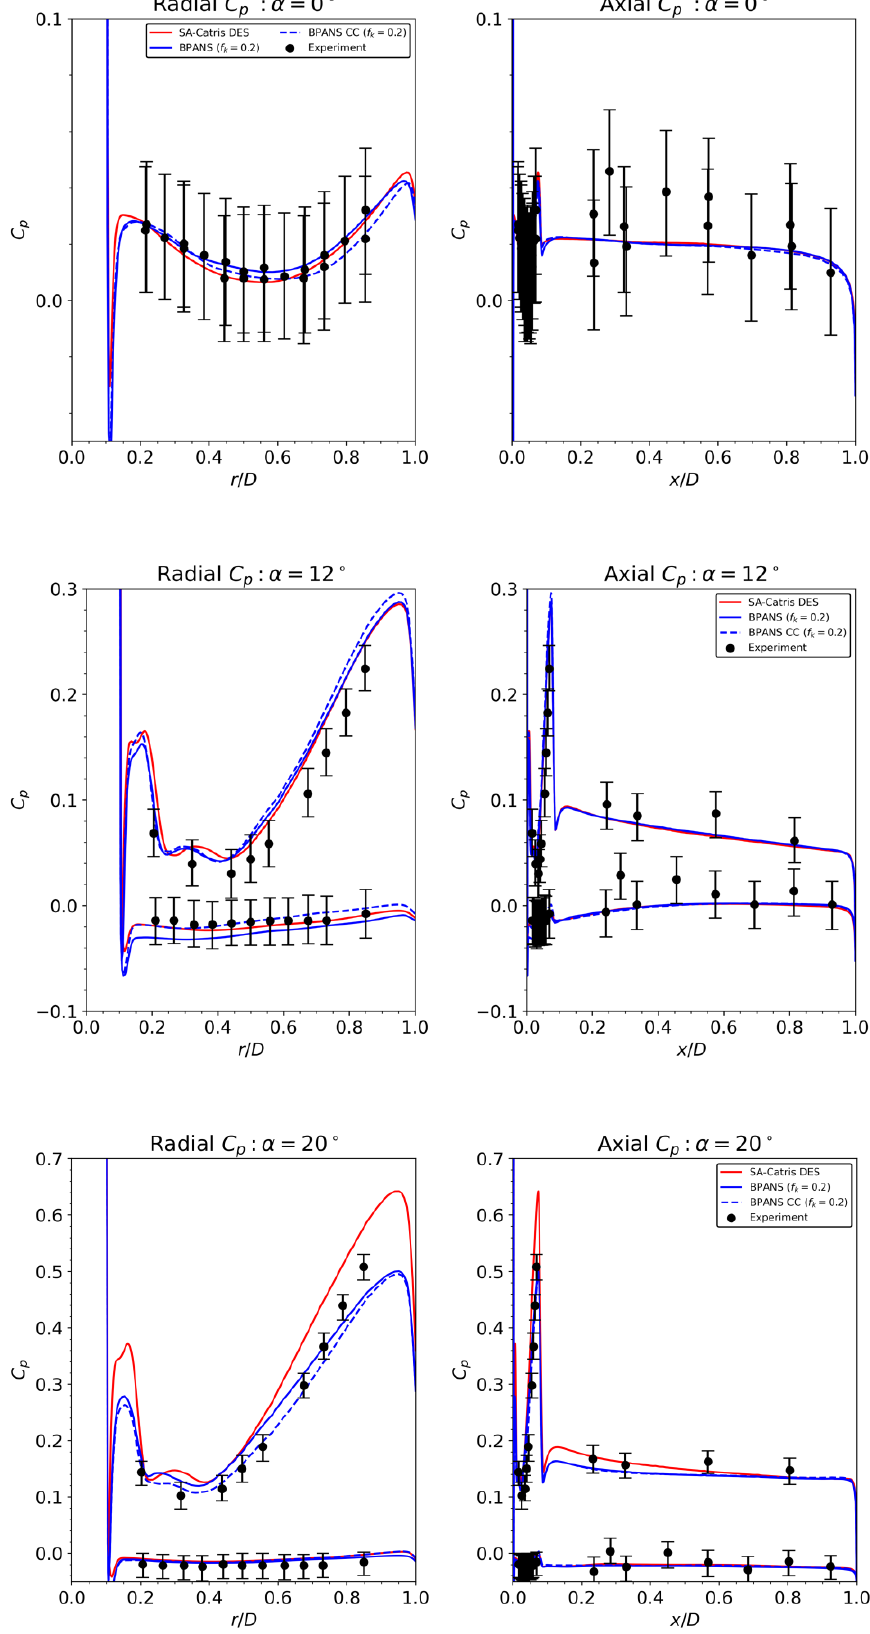
Figure 6. Surface pressure coefficient statistics for the SRP configuration.